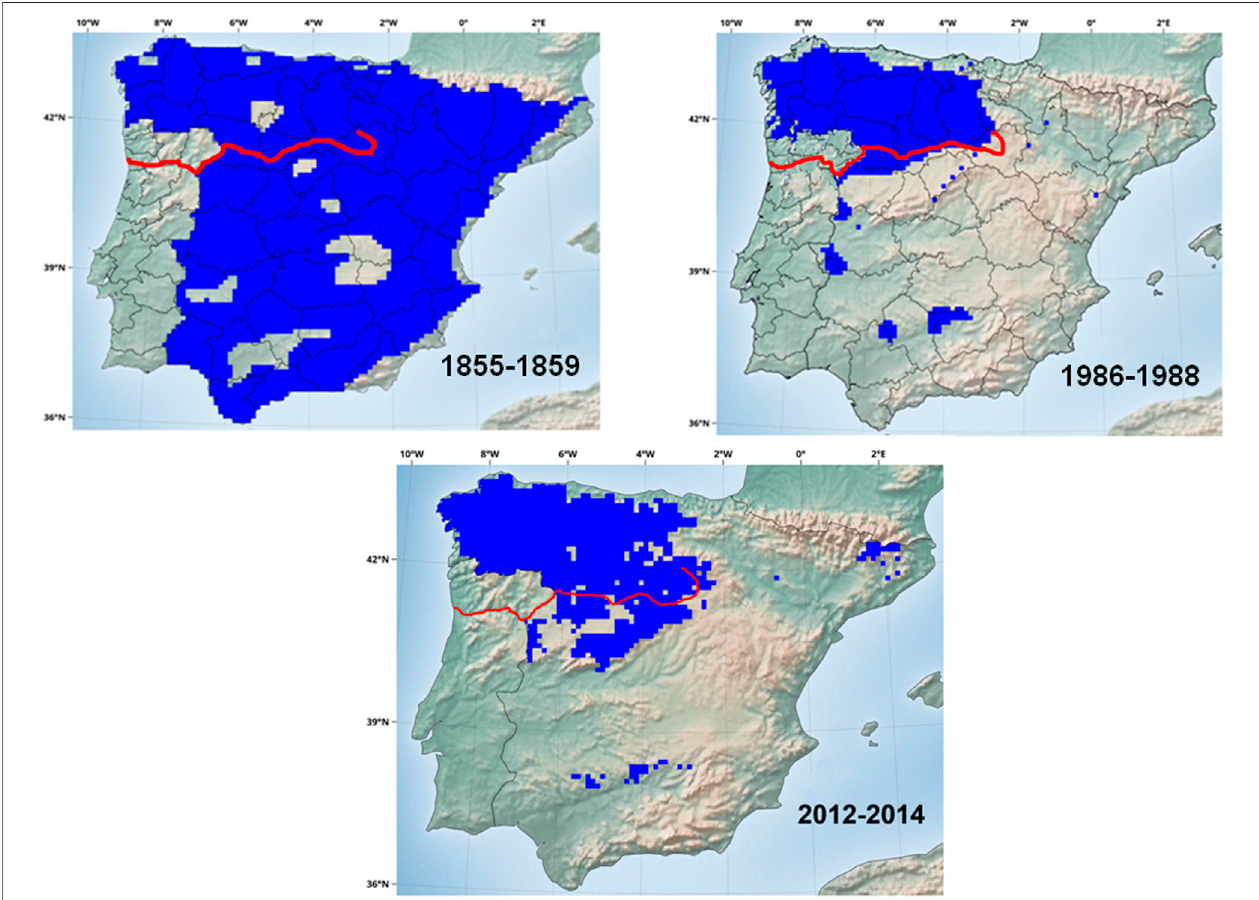
FIGURE 1 | Wolf range in Spain in 1855 – 1859 (adapted from Rico and Torrente, 2000), in 1986 – 1988, and in 2012 – 2014 (adapted from Blanco et al., 1992 and MAGRAMA, 2016, respectively). Douro river, which has been dividing wolf management regimes in Spain, is also shown (red line). We projected the original maps on a 10 km UTM grid size for a more standardized overview in terms of accuracy and comparison of range